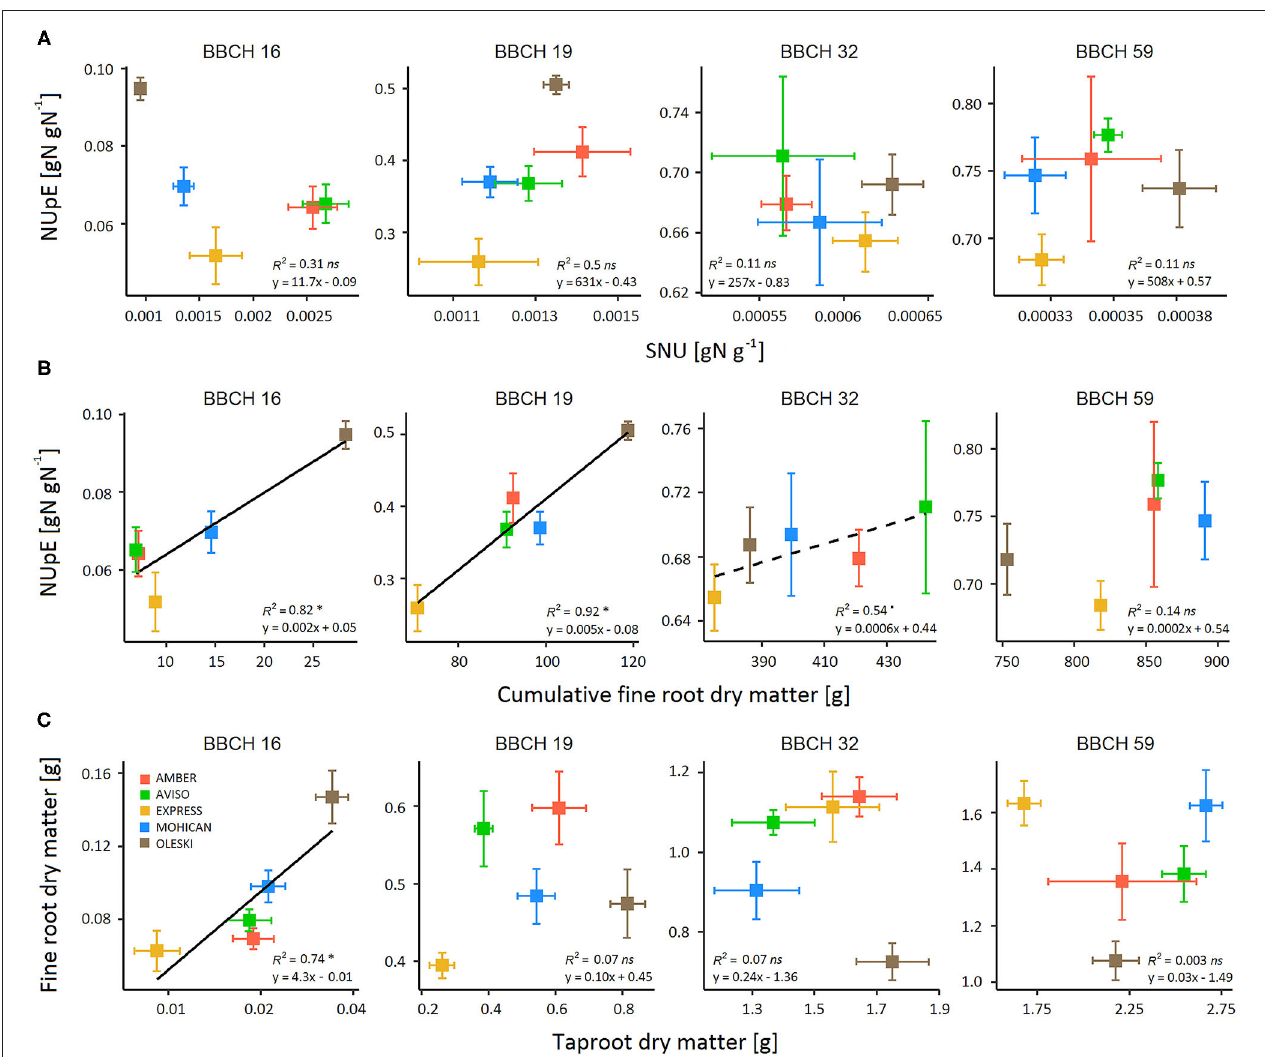
FIGURE 5 | Relationship between (A) NUpE and specific N uptake (SNU), (B) Nitrogen Uptake Efficiency (NUpE) and cumulative fine-root dry matter, and (C) fine root and tap root dry matter during the vegetative growth (BBCH 16–59) for five winter oilseed rape genotypes under low-N conditions (GR18 experiment). Colored squares indicate the mean value per genotype. Error bars indicate standard errors of the mean of each genotype with n = 7–8 at each sampling date. Significant regressions at P- value < 0.05 are indicated by a solid line and (*) symbol, while significant regressions at P- value < 0.1 are indicated by a dashed line and (.)